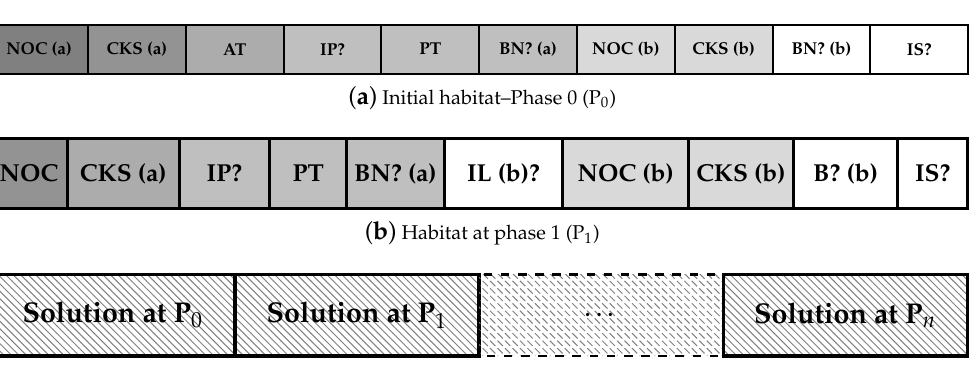
Figure 3. Encoding of the neural networks during the various phases. In phase 0, there are two convolutional layers, called ( a , b ). For the abbreviations, see Table 2. In phase 1 and subsequent phases, which are identical, the activation type is no longer changed (therefore no AT in those phases), but it can be decided if a second layer is included (IL?). The concatenation of the phases is shown in subfigure ( c ). Yes/no hyperparameters are shown with a?